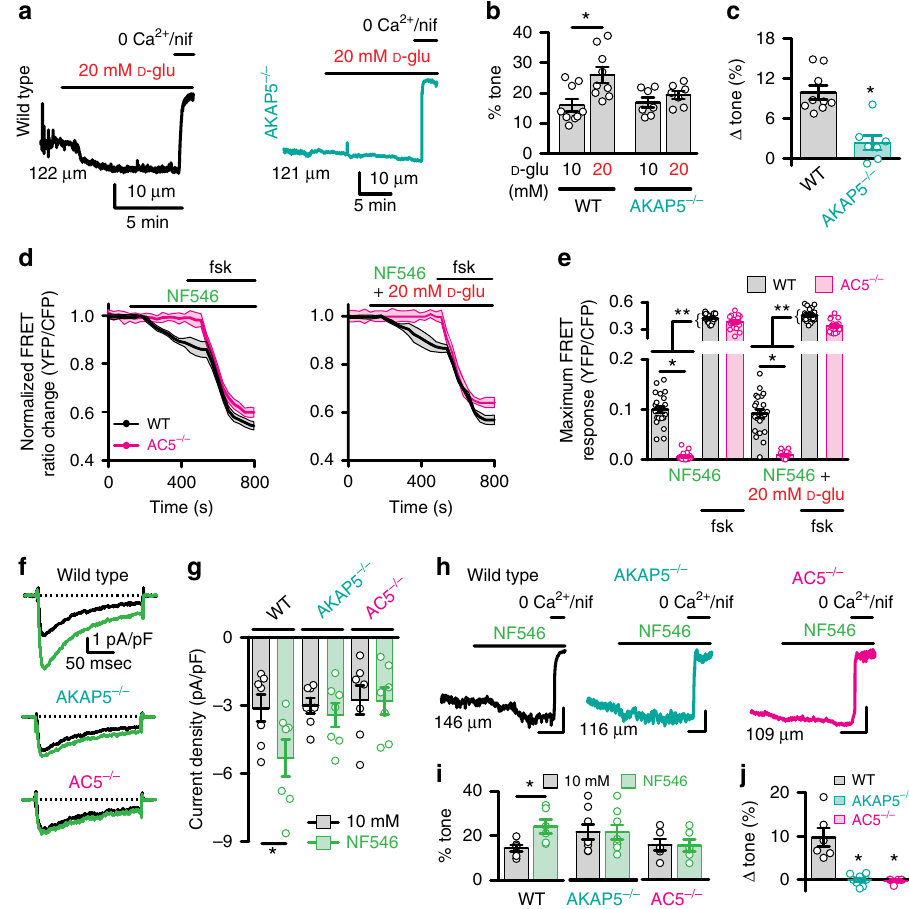
Fig. 3 AKAP5/AC5 mediate I Ba potentiation and vasoconstriction upon glucose/NF546. Representative a diameter recordings, b summary percentage myogenic tone, and c change in myogenic tone from wild-type (WT; n = 9 arteries/5 mice) and AKAP5 − / − ( n = 7 arteries/6 mice) cerebral arteries in 10 and 20 mM D-glucose (D-glu). * P < 0.05 with two-tailed Wilcoxon test for b ( P = 0.0039 for WT 10 mM D-glu-20 mM D-glu) and two-tailed Mann – Whitney test for c ( P = 0.0012 for WT-AKAP5 − / − ). d Averaged ICUE3-PM traces (mean = solid line; SEM = shade) and e maximum FRET ratio for WT and AC5 − / − arterial myocytes upon 500 nM NF546 ( n = 23 cells/6 WT mice; n = 18 cells/5 AC5 − / − mice), 20 mM D-glu + 500 nM NF546 ( n = 22 cells/6 WT mice; n = 15 cells/5 AC5 − / − mice) and after 1 µ M forskolin. * P < 0.05 with two-tailed Mann – Whitney test. Single asterisks highlight signi fi cant differences between datasets in the absence of forskolin. Double asterisks indicate statistical differences within the same experimental group before and after forskolin. All signi fi cant P values are <0.0001. f Exemplary I Ba traces and g amalgamated current density from WT ( n = 7 cells/5 mice), AKAP5 − / − ( n = 7 cells/5 mice) and AC5 − / − ( n = 7 cells/3 mice) cerebral arterial myocytes before and after 500 nM NF546. * P < 0.05 with two-tailed Wilcoxon test. P = 0.0156 for WT 10 mM D-glu-NF546. h Representative diameter recordings, i summary percentage myogenic tone, and j change in myogenic tone from WT ( n = 6 arteries/4 mice), AKAP5 − / − ( n = 8 arteries/6 mice), and AC5 − / − ( n = 6 arteries/4 mice) cerebral arteries exposed to 500 nM NF546. Scales = 10 μ m (vertical) and 5 min (horizontal). * P < 0.05 with two-tailed Wilcoxon test for Dii ( P = 0.0313 for WT 10 mM D-glu-NF546) and Kruskal – Wallis one-way ANOVA with Dunn ’ s multiple for Diii ( P = 0.0036 for WT-AKAP5 − / − and P = 0.0040 for WT-AC5 − / − ). Initial diameters shown on the traces left side. Data represent mean ± SEM. Source data are provided as Source data fi